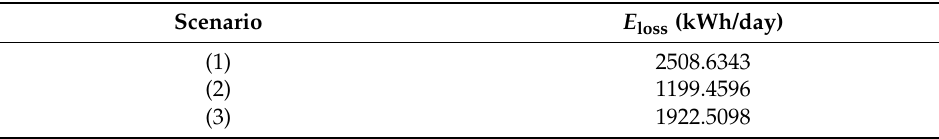
Table 6. Power losses for 33-node system